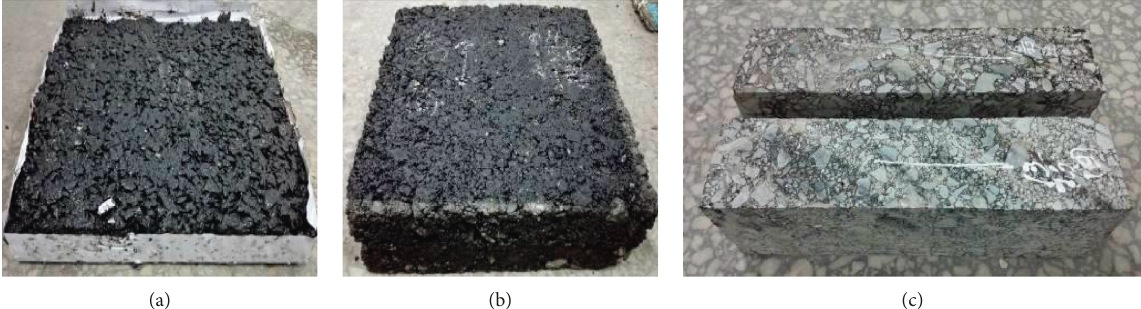
Figure 4: Rut and beam specimens. (a) Rut specimen (single-deck). (b) Rut specimen (double-deck). (c) Beam